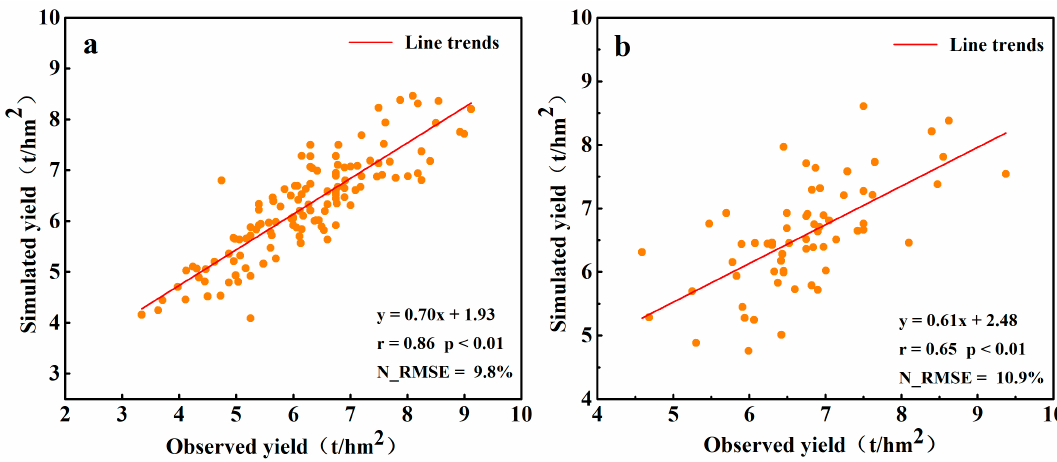
Figure 6. The EPIC crop model verification result at all 16 agrometeorological stations. ( a ) The calibration result based on the yield record from 1999 to 2008, ( b ) the validation result based on the yield records from 2009 to 2011.